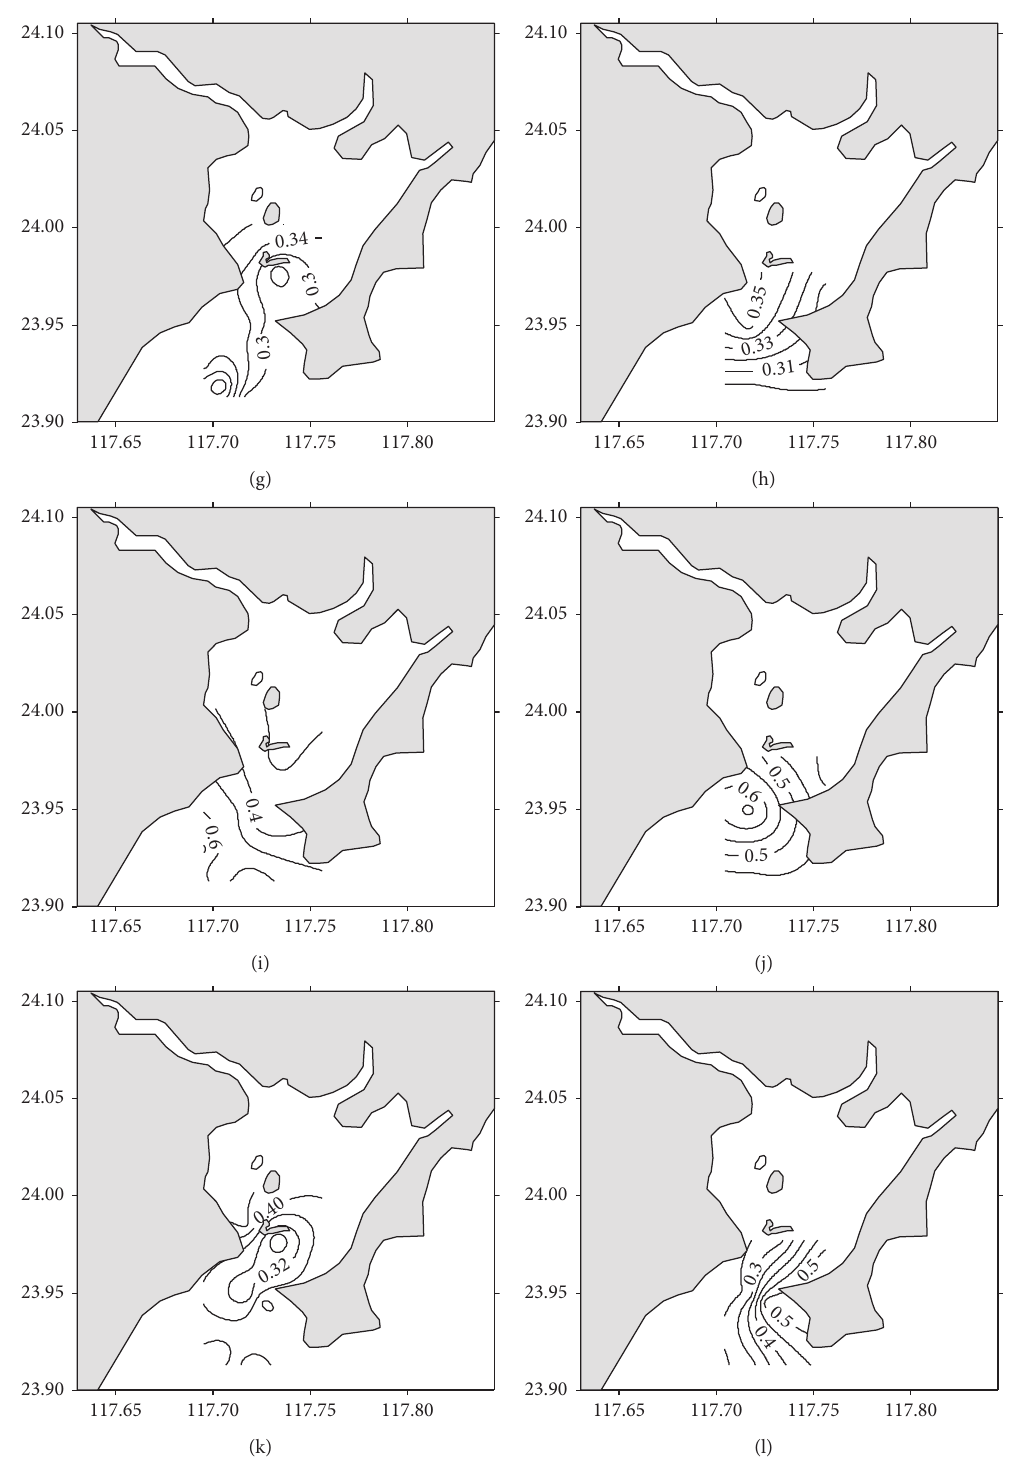
Figure 2: Distributions (surface layer, left panels; bottom layer, right panels) of various heavy metals in the seawater of Jiuzhen Bay ( μ g/L): (a) Cu Sur; (b) Cu Bot; (c) Zn Sur; (d) Zn Bot; (e) As Sur; (f) As bot; (g) Cd Sur; (h) Cd Bot; (i) Hg Sur; (j) Hg Bot; (k) Pb Sur; (l) Pb